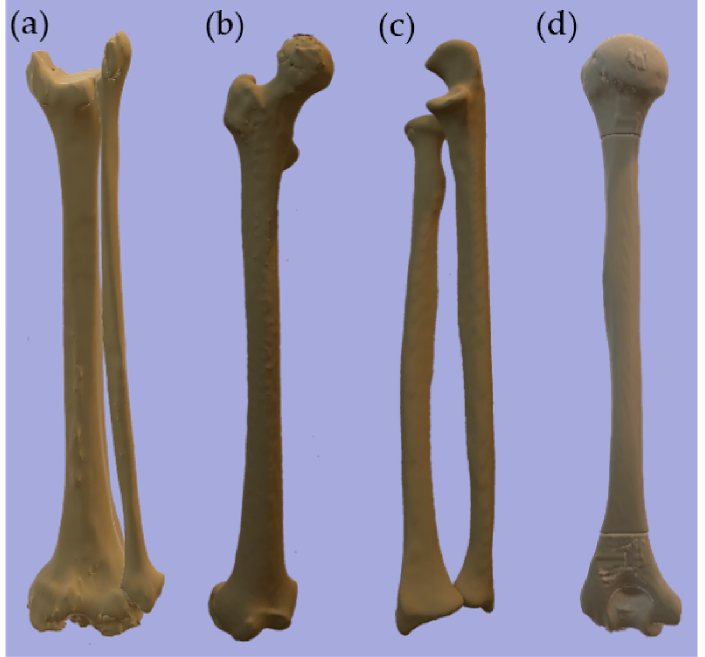
Figure 1. 3D models of bones. From the left: ( a ) Tibia and Fibula, ( b ) Femur, ( c ) Ulna and Radius, ( d ) Humerus.